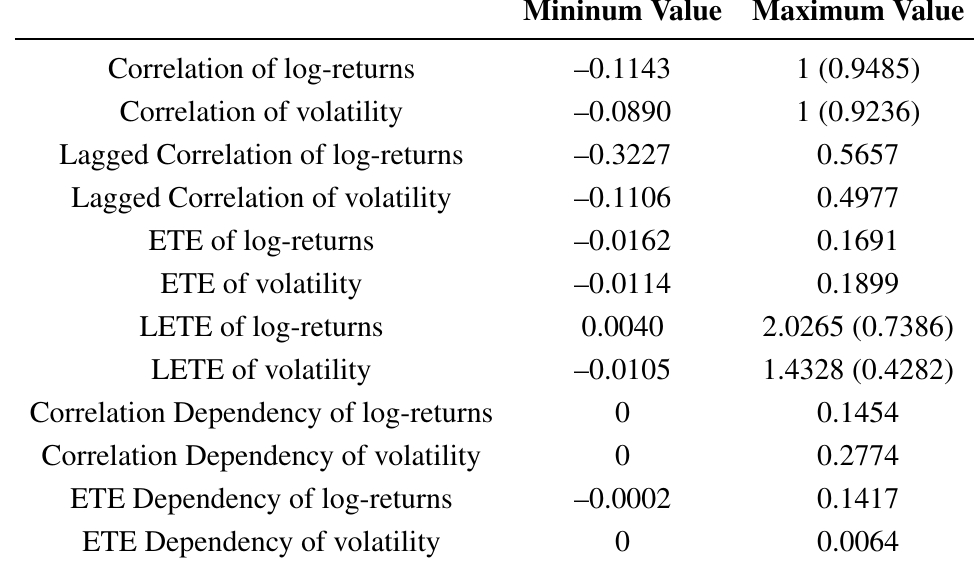
Table 3. Minimum and maximum values of Correlations, ETEs, and dependencies, for log-returns and for volatility, for original and lagged matrices. Numbers in brackets show maximum off-diagonal values.